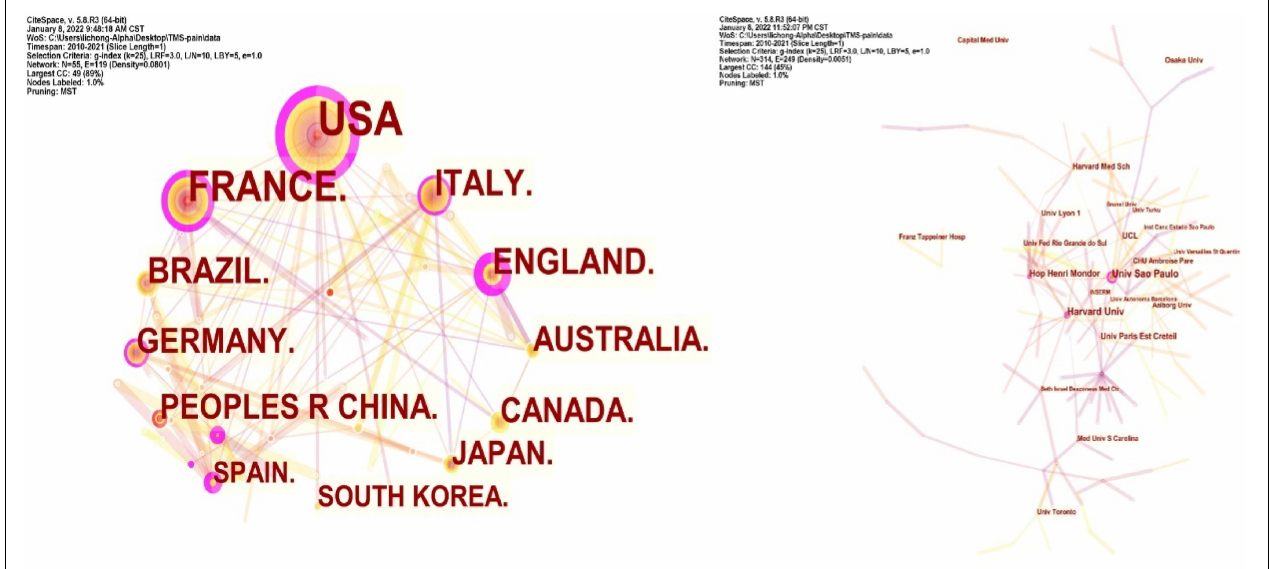
FIGURE 9 | Network map of countries and institutions in TMS in pain research.